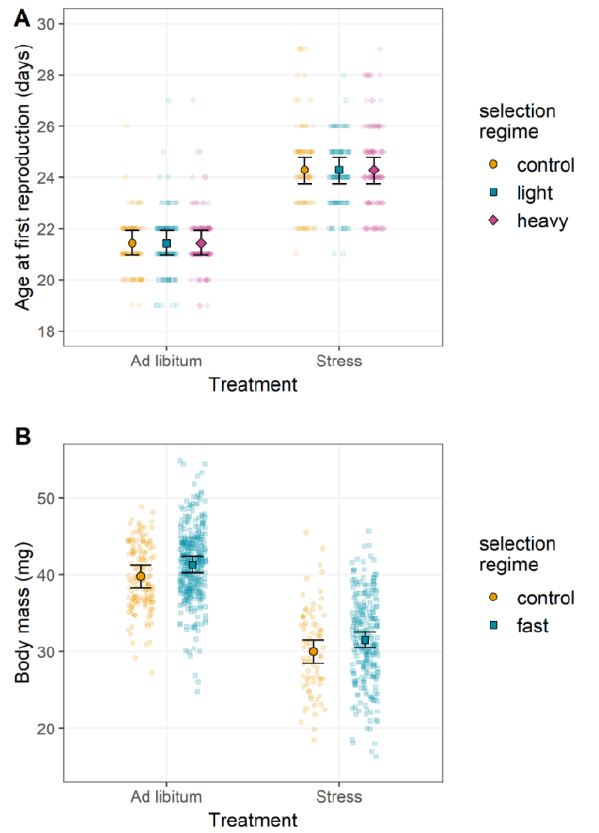
Figure 3: Reciprocal phenotypic responses to selection on female body mass and age at first reproduction. (A) Age at first reproduction of G9 individuals from the selection on female body mass. Diet but not selection regime significantly affected age at first reproduction. (B) Female body mass of G10 individuals from the selection on age at first reproduction. Female body mass was significantly influenced by diet and marginally by selection regime. Color code is similar to Figure 1. Error bars represent standard errors between